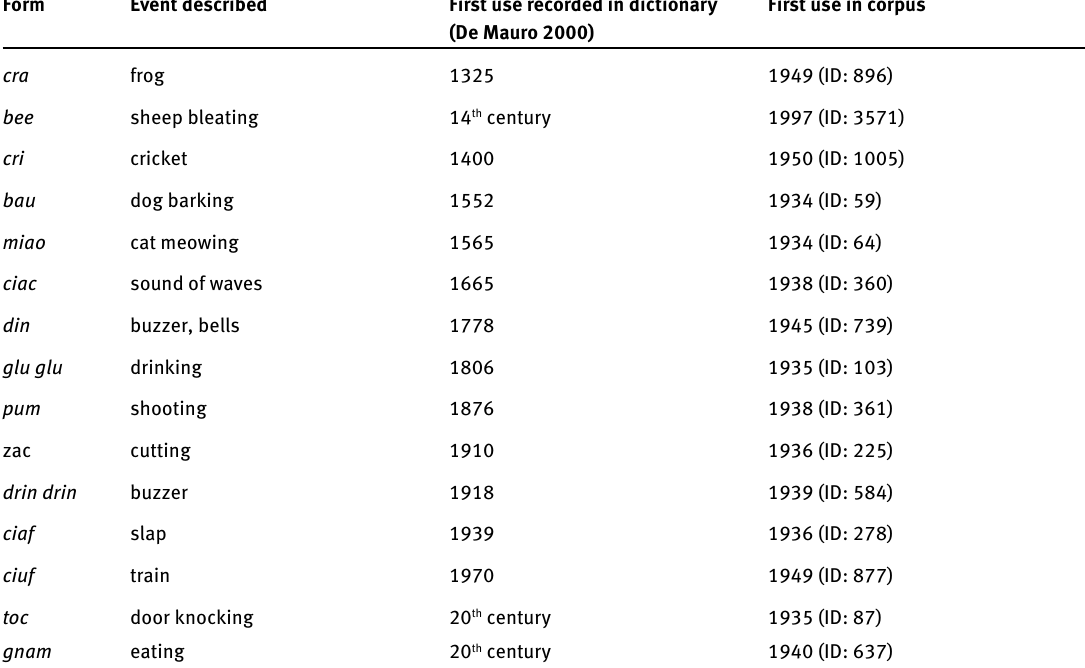
Table 3. List of Italian lexicalised